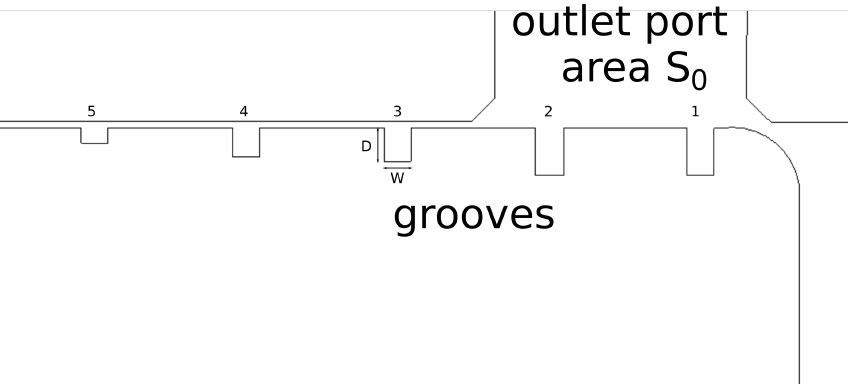
Figure 1. 3D view of cylinder, with the outlet port, and the piston with five grooves, in position R12.